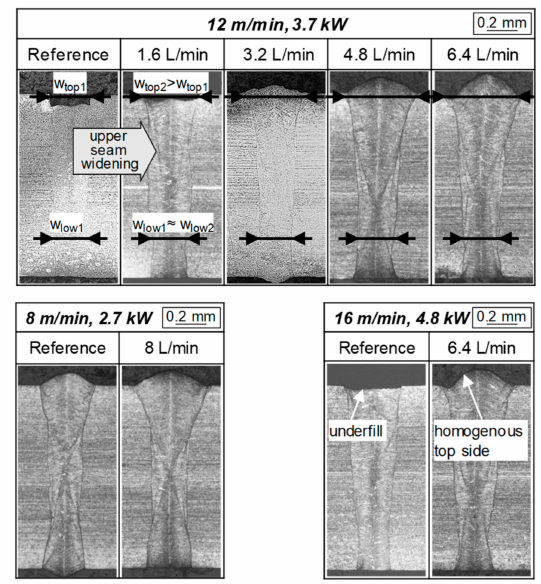
Figure 10. Cross sections of weld seam geometries depending on flow rate and welding